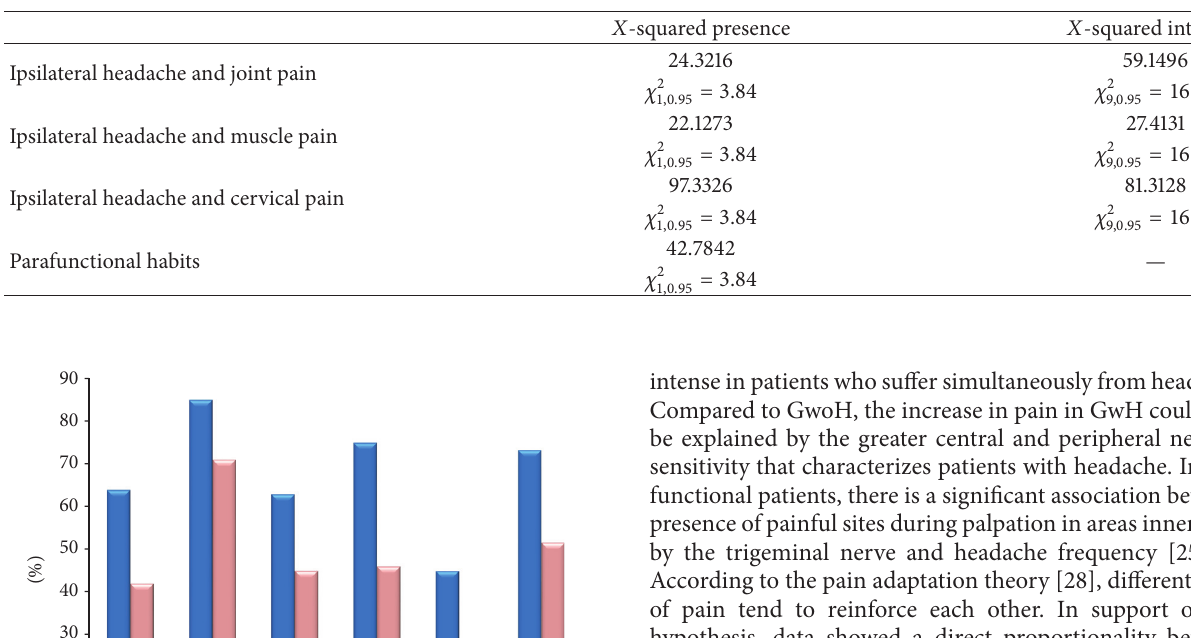
Table 4: 𝑋 -squared value of correlation between presence and intensity of headache and presence and intensity of muscle, joint, and/or cervical ipsilateral pain and between presence of headache and presence of parafunctional habits.